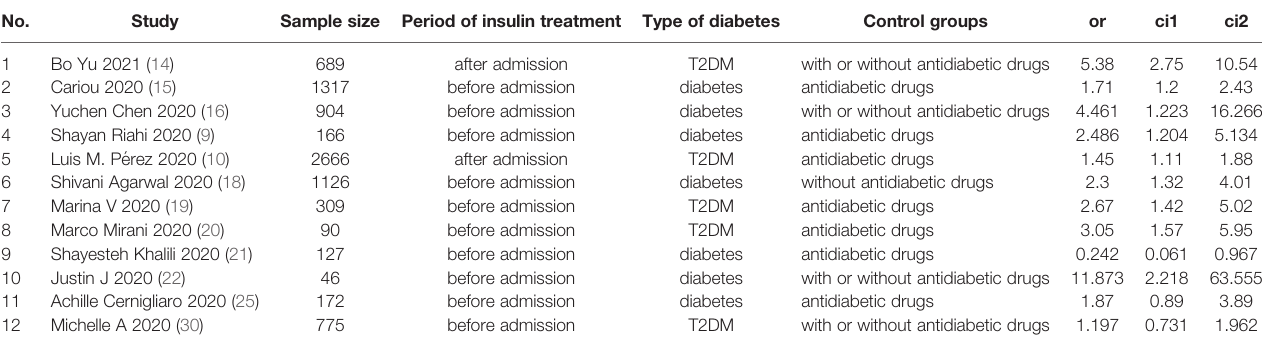
TABLE 2 | Description of studies reporting the association between insulin treatment and the mortality of COVID-19. No. Study Sample size Period of insulin treatment Type of diabetes